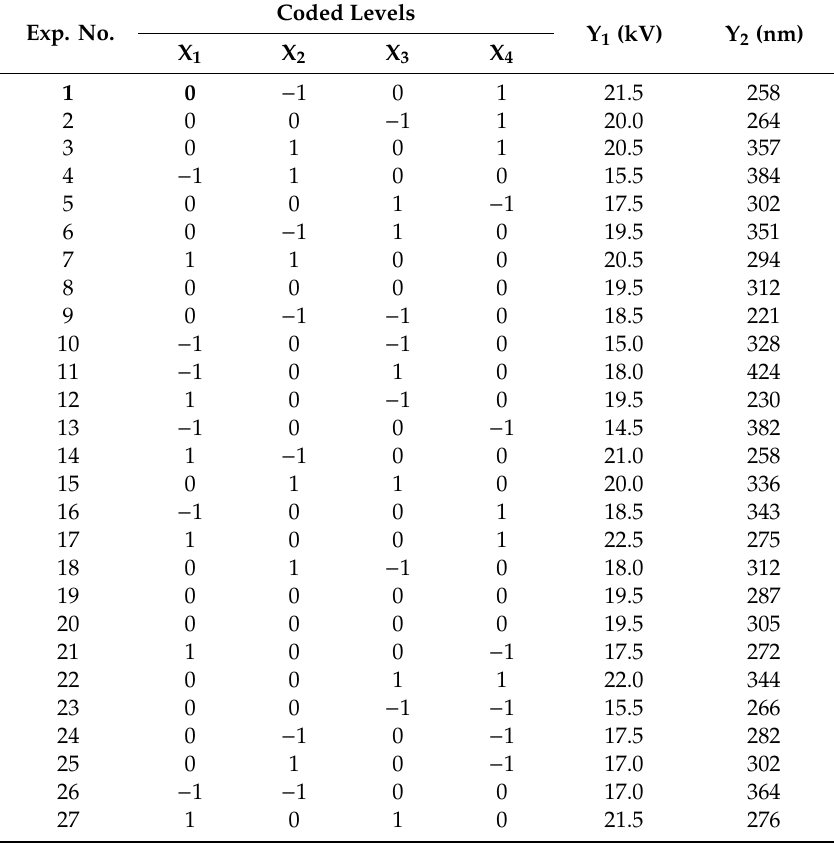
Table 3. Experimental responses of the dependent variables for the applied voltage (Y 1 ) and the average PES nanofiber diameter (Y 2 ) in the Box-Behnken design. X 1 : LiCl concentration (% ( w / v )), X 2 : PES concentration (% ( w / v )), X 3 : Feed rate (mL / h), X 4 : Tip-to-collector distance (cm). The real values of the independent variables are listed in Table